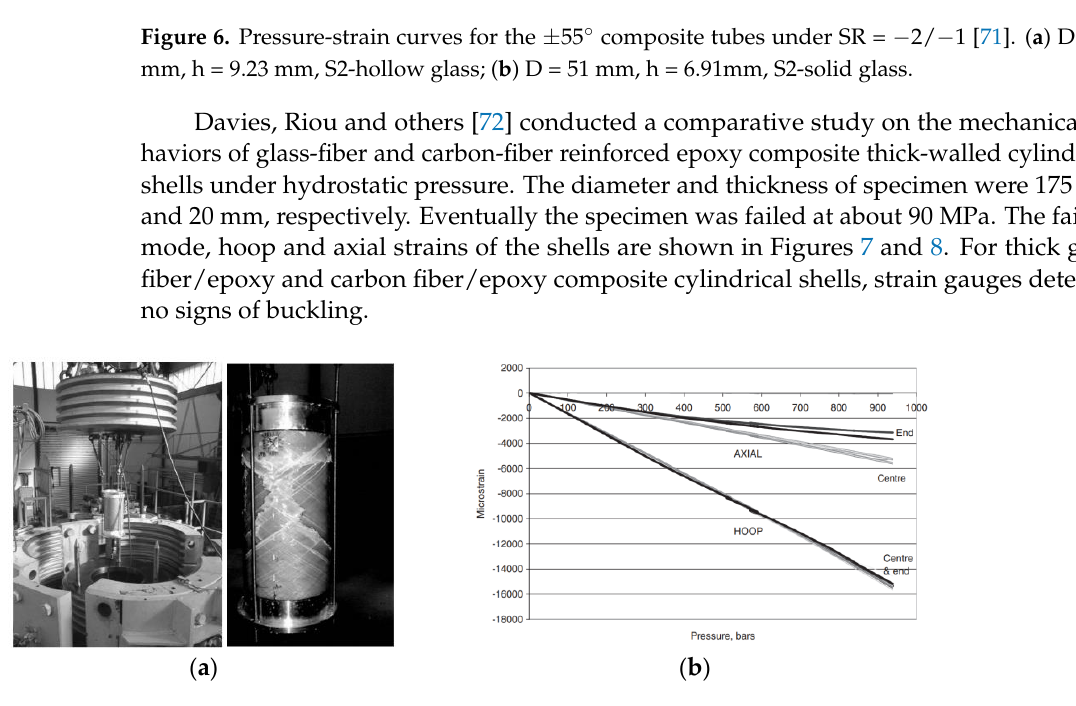
Figure 7. Experimental results of thick glass fiber reinforced epoxy composite tube under hydrostatic pressure [72]. ( a ) cylinders after implosion ( b ) axial and hoop strain response.